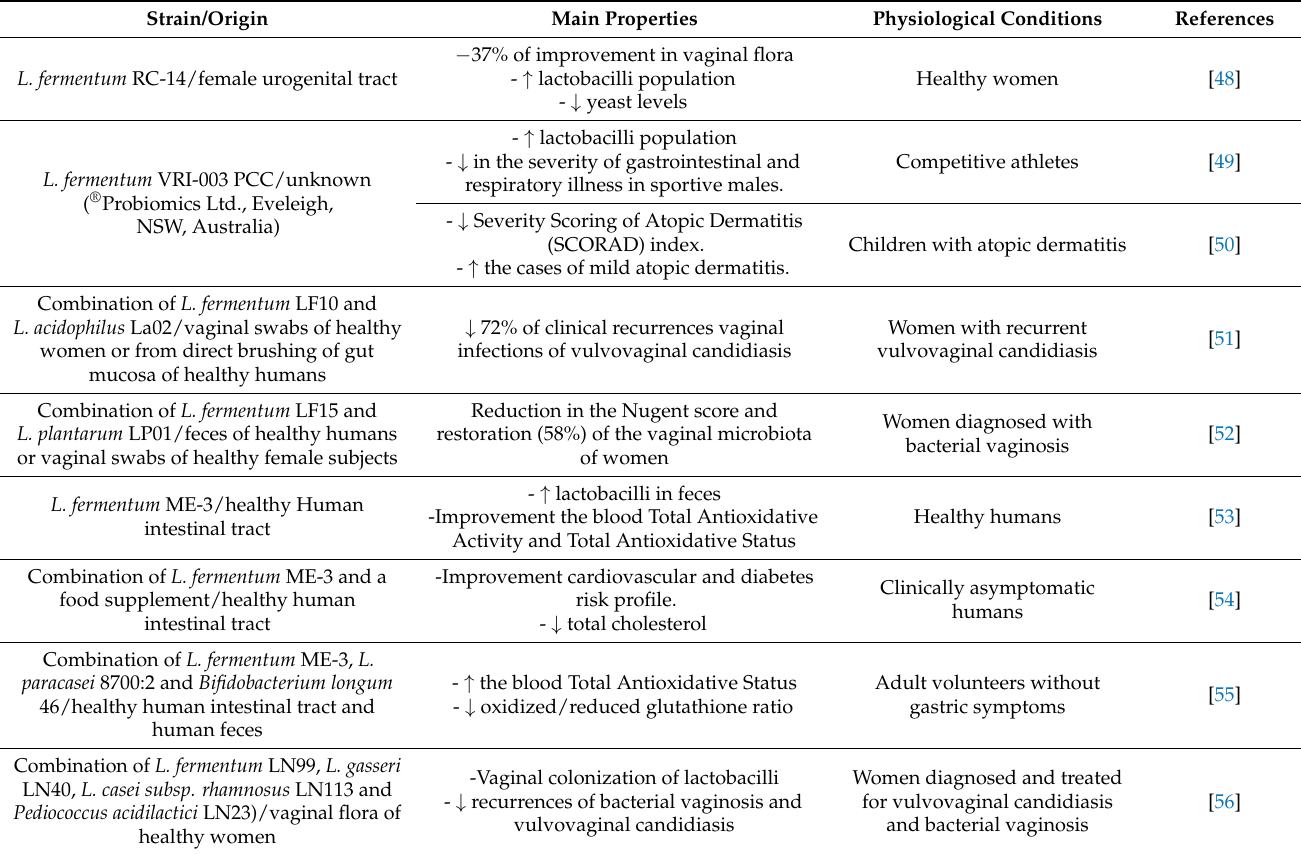
Table symbols: ↓ Reduction and ↑